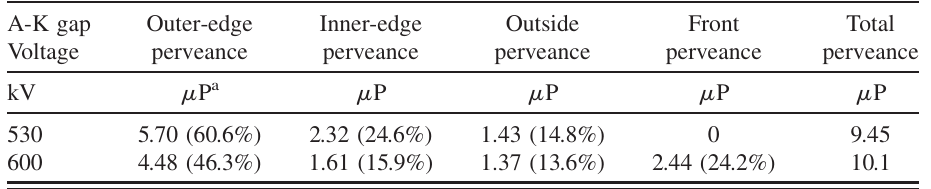
TABLE I. Partial perveances before and after the front emission in MAGIC2D simulation.